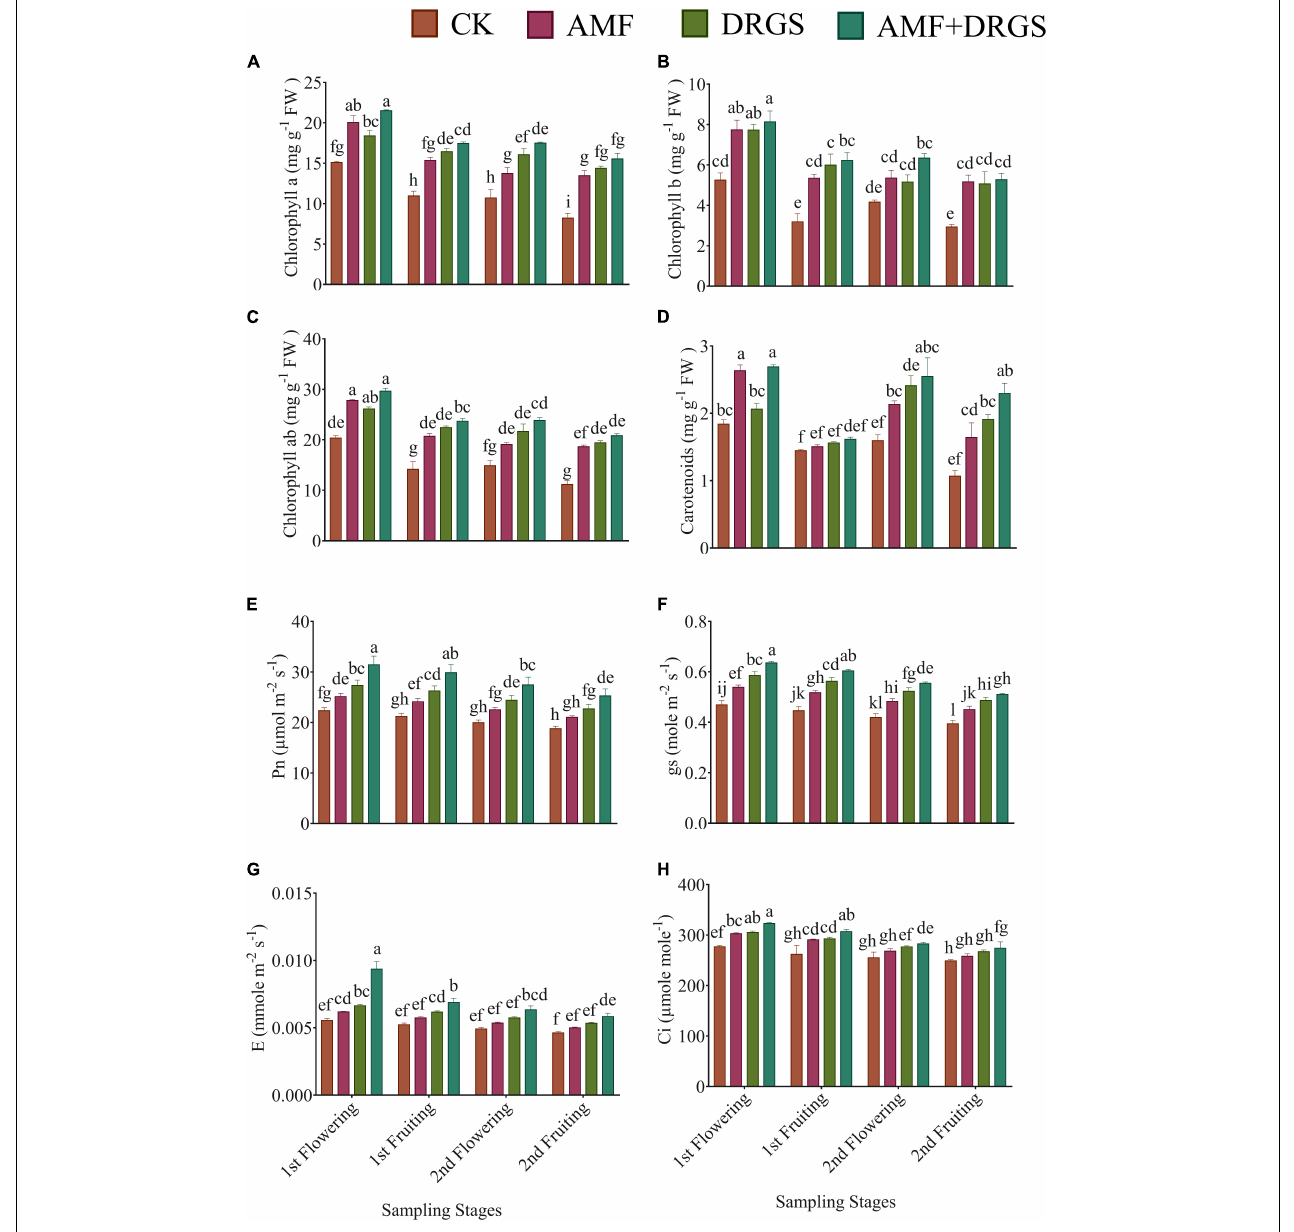
FIGURE 3 | Effect of AMF inoculation and amendment with dry raw garlic stalk on (A) chlorophyll a , (B) chlorophyll b , (C) chlorophyll ab and (D) carotenoids content, (E) photosynthesis (Pn), (F) stomatal conductance (gs), (G) transpiration rate (E), and (H) internal CO 2 (Ci) on eggplant leaves at 1st flowering, 1st fruiting, 2nd flowering, and 2nd fruiting stages. Data represent the means of ± S.E. ( n = 5). Different letters show significant differences within treatments. Tukey’s HSD test was employed to verify statistical significance at p <